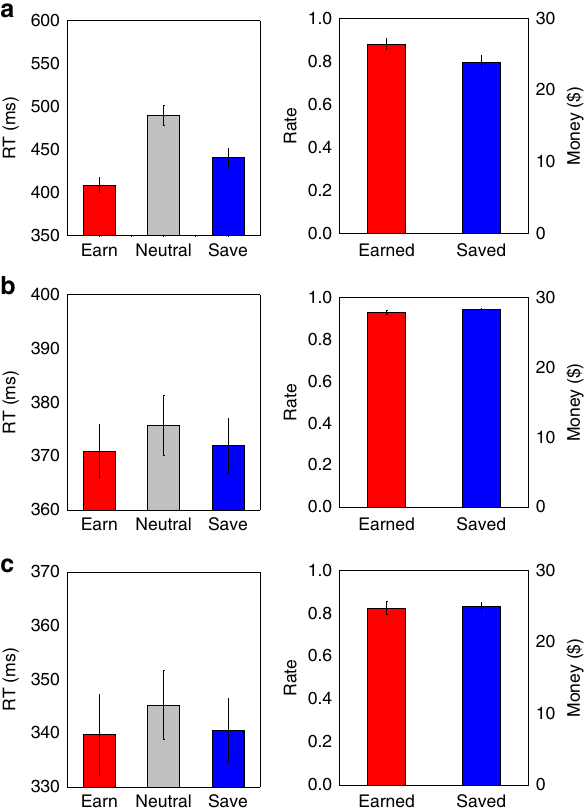
Fig. 2 Value reinforcement task: response time, rate of correct responses, and payout. Top row ( a ): value reinforcement data in experiment 1a. Left panel, response time (RT, ms); right panel, successful earnings and savings in rate and cash. Middle row ( b ), value reinforcement data in experiment 1b; and bottom row ( c ), value reinforcement data in experiment 1c. For all, error bars indicate standard errors of the mean (SEM). See text for